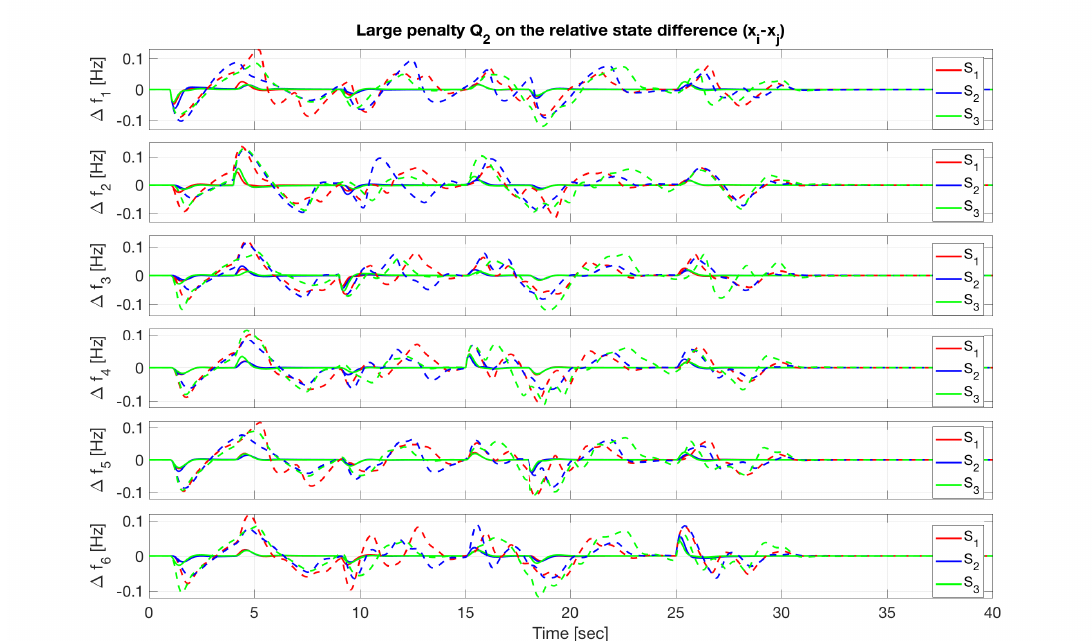
Figure 11. Frequency transients of the six-area power system for three tie-line interconnection schemes ( S ) . Large penalty on relative state-difference between interconnected areas. Solid lines depict 1 , S 2 , S 3 transients of the linear model; dashed lines depict transients of the model with saturator (Figure 8).